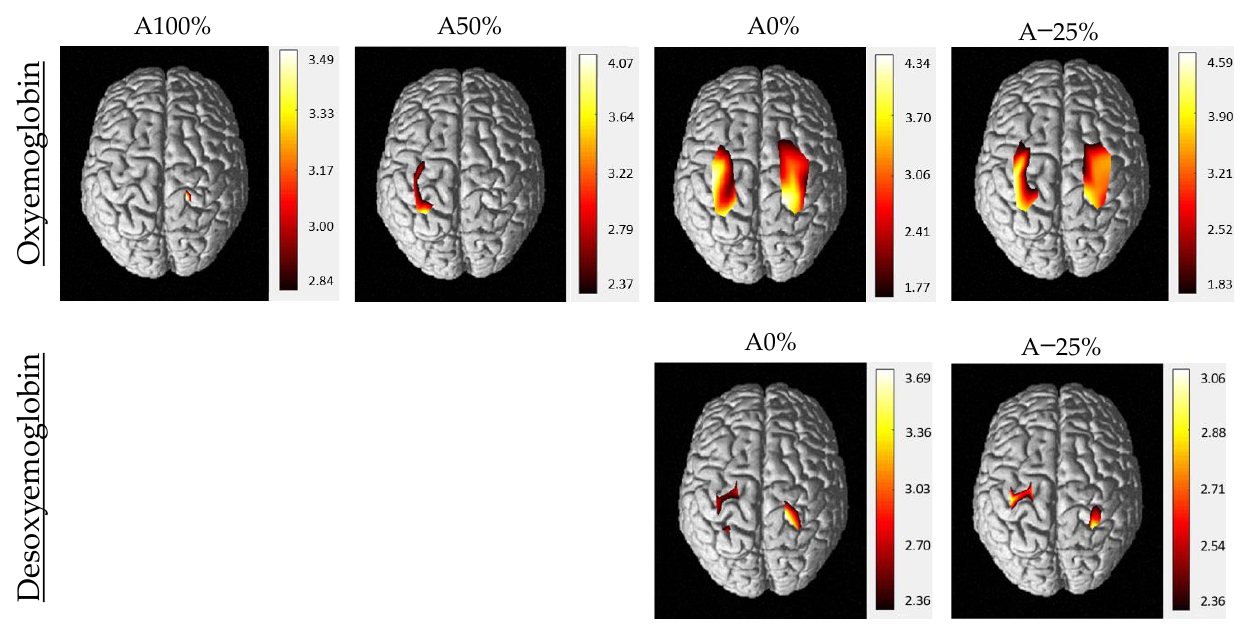
were organized according to the anatomical correspondence using the EEG 10/20 system. The time window analyzed was 45 s, from 10 s before the beginning of the task to 35 s after the task. The red traces indicate HbO 2 levels and the blue traces indicate HbR levels. The red boxes indicate a signif- icant difference between rest and task periods for HbO 2 levels. The blue boxes indicate a significant difference between rest and task periods for HbR levels. * p < 0.05 ; ** p < 0.01 (Benjamini – Hochberg correction).